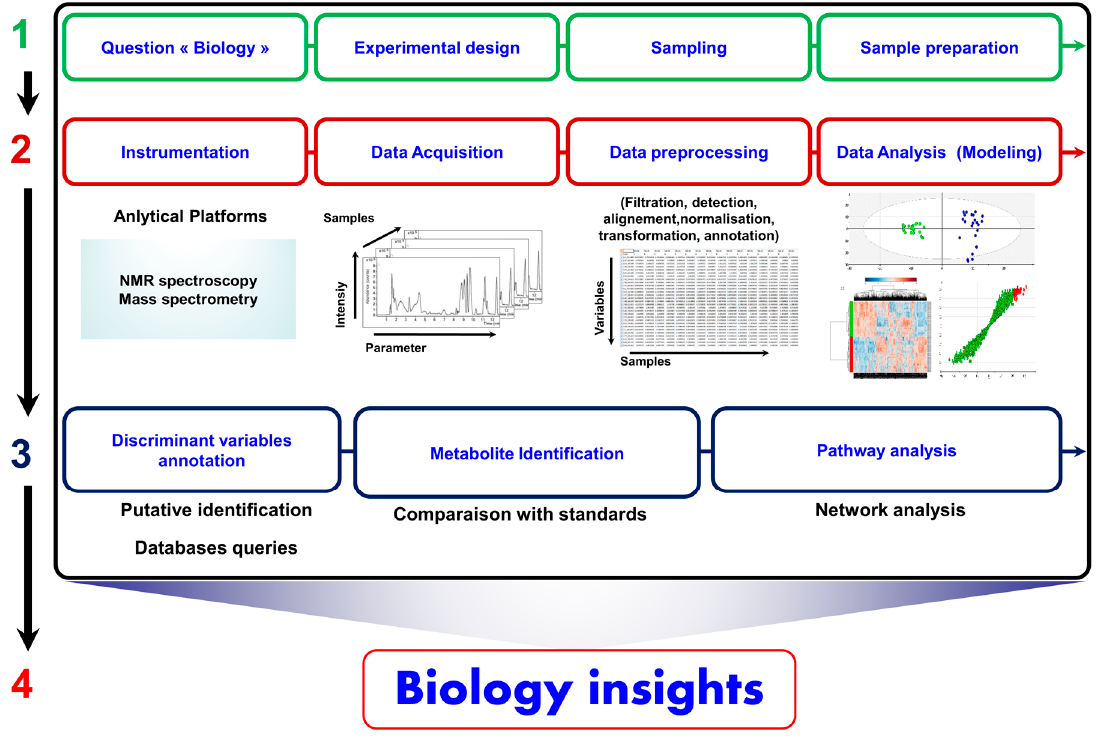
Figure 1. Translational metabolomics workflow.